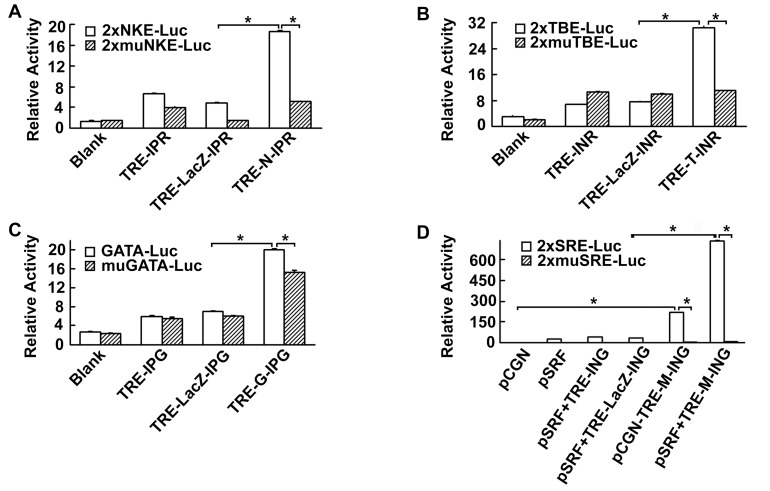
Nkx2-5, Tbx5, Gata4 and Myocd lentiviral vectors transactivated cis-element reporters containing cognate sequences of Nkx2-5, Tbx5, Gata4, and Srf binding sites.CV-1 cells were cotransfected with Tet-transactivator vector, corresponding luciferase reporters, and one or more of Nkx2-5, Tbx5, Gata4, Myocd, or LacZ tetracycline-dependent lentiviral vectors. Dual-luciferase assays were performed 48 hours after doxycycline induction. (A) TRE-Nkx2-5-IPR transactivated NKE cis-element reporter. (B) TRE-Tbx5-INR transactivated TBE cis-element reporter. (C) TRE-Gata4-IPG transactivated GATA cis-element reporter. (D) TRE-Myocd-ING transactivated SRE cis-element reporter in the presence of Srf. Each experiment was performed in quadruplicate. Blank, without the addition of tetracycline-dependent lentiviral vector; TRE-IPR, TRE-INR, TRE-IPG, and TRE-ING are empty vector controls for Nkx2-5, Tbx5, Gata4, and Myocd lentiviruses. TRE-LacZ-IPR, TRE-LacZ-INR, TRE-LacZ-IPG, and TRE-LacZ-ING are LacZ vector controls for Nkx2-5, Tbx5, Gata4, and Myocd lentiviruses. TRE-N-IPR, TRE-T-INR, TRE-G-IPG, and TRE-M-ING are Nkx2-5, Tbx5, Gata4, and Myocd lentiviruses. *P<0.01 vs LacZ groups.